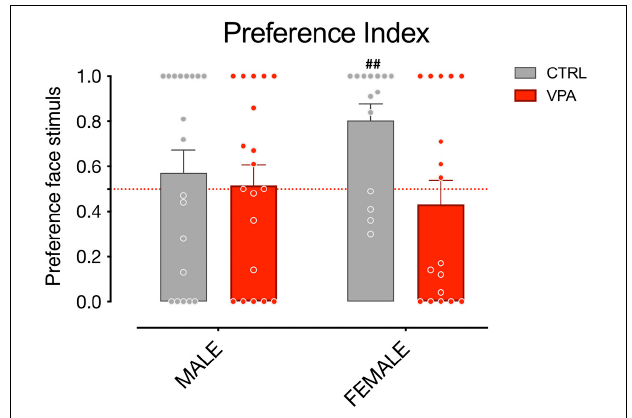
FIGURE 3 | Social preference index of sex groups. Bar graphs represent social preference indexes for males and females. One-sample t -test on preference indexes indicate a significant difference from chance level for female control animals, but not for males or VPA-treated chicks of both sexes. The number sign (#) indicate significant departures of the preference index from chance level (0.5), marked by the red line. Data represents Mean ± SEM, ## uncorrected p <